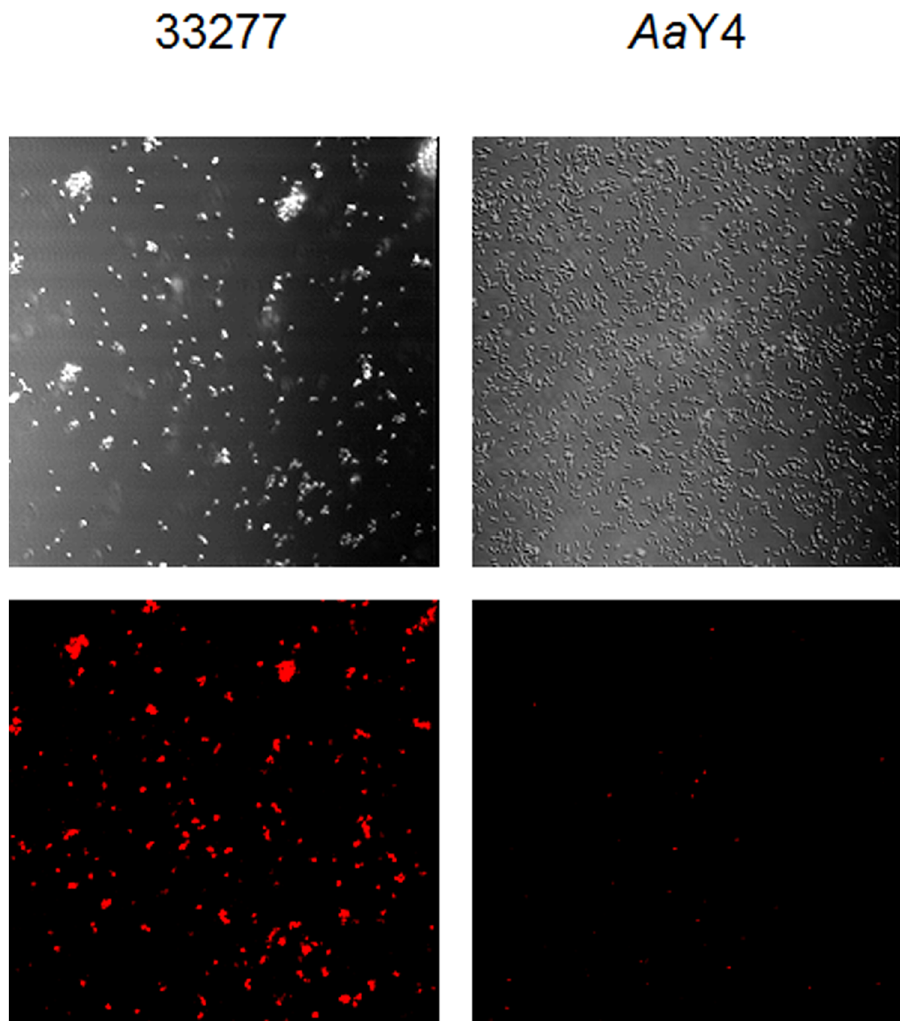
Figure 2. Immunofluorescence antibody images of the interaction of P . gingivalis 33277 or A . actinomycetemcomitans Y4 with ArcA. The upper panel presents differential interference contrast (DIC) images showing the location of the bacteria. The lower panels are the TRITC fluorescence labeling (red) images showing bacterial-associated ArcA. Bar is 5 µ